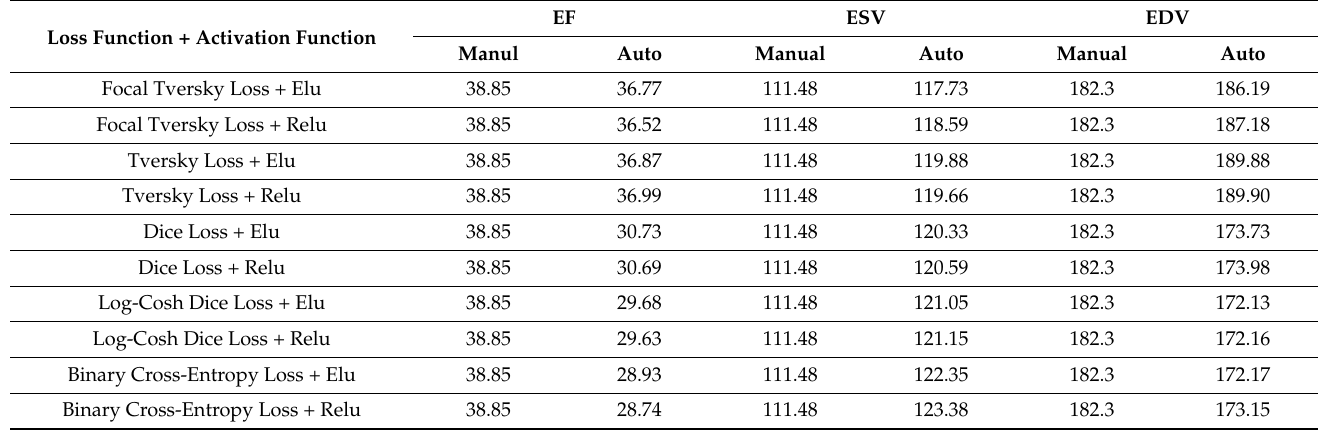
Table 19. Comparison of the clinical metrics of all models proposed in this research.